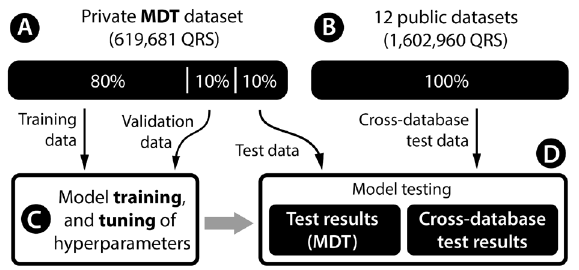
Figure 3. Dataflow in the presented study: private MDT data ( A ) were split into training, validation, and test subsets. Training and validation subsets were used to develop the proposed method ( C ). Next, the method performance was measured ( D ) using MDT private test data and data from twelve public databases ( B ). For the QRS classification task, only four databases were used.